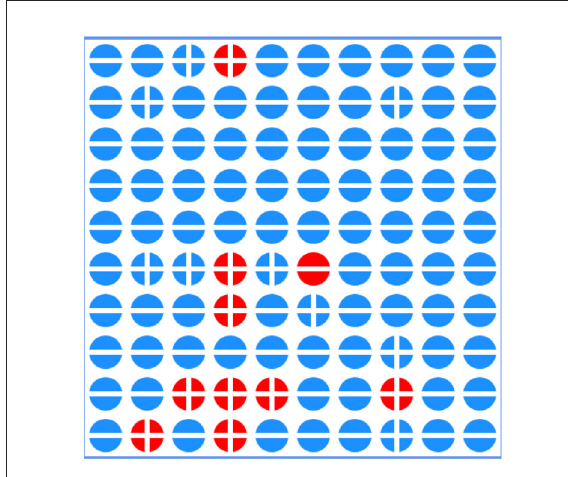
FIGURE3 In this array 100 patients are represented by round icons. A red icon represents a patient with the disease, while a blue icon corresponds to a healthy patient. The signs + and – represent positive and negative tested patients.